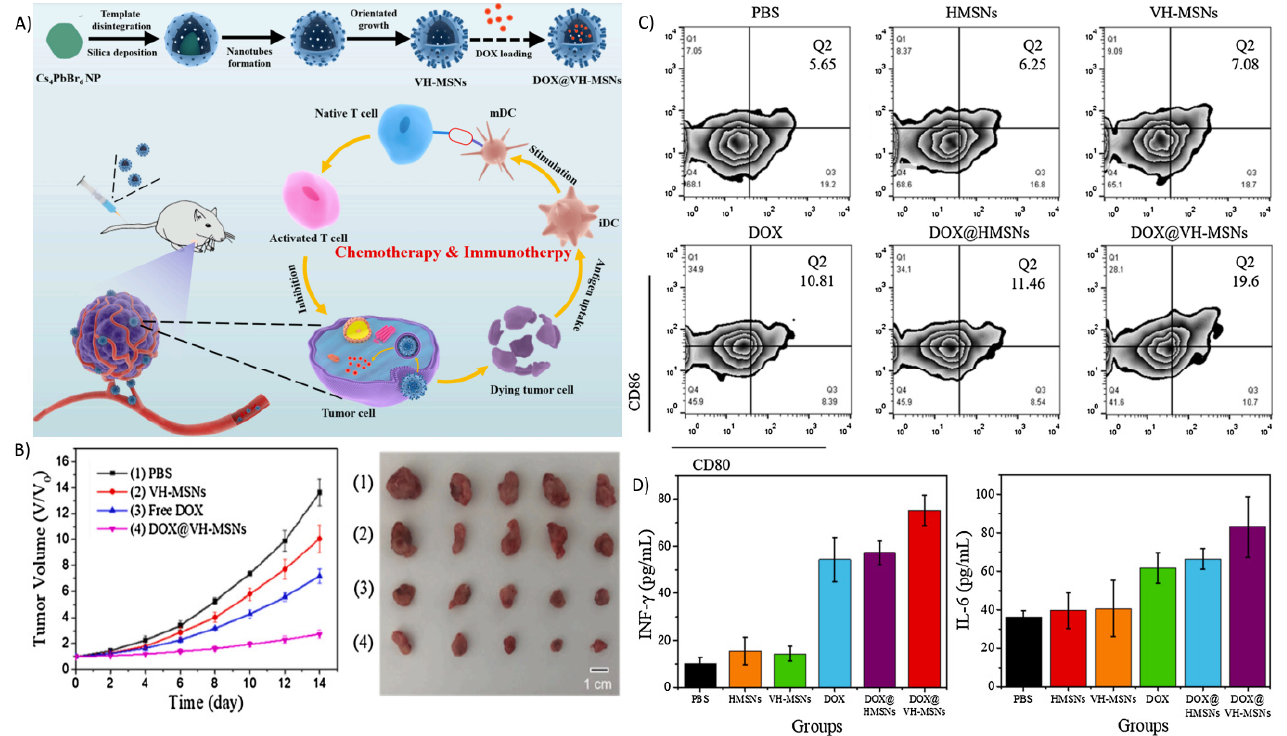
Figure 8. A virus-like hollow mesoporous silica nanoparticle was loaded with DOX. ( A ) Design scheme of the VH-MSN. ( B ) Tumor growth curve of 4T1 cells and the photograph of tumors collected posttreatment ( C , D ) Flow cytometry of the percentage of CD80 + and CD86 + matured APCs and the serum levels of cytokine IFN- γ and IL-6. Reprinted (adapted) with permission from Ref. [138]. Copyright 2021, Elsevier.